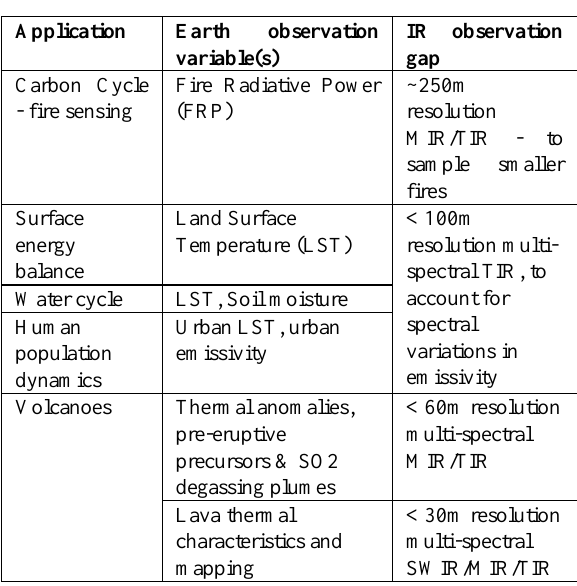
Table 1. Science and operational gaps in mid- and